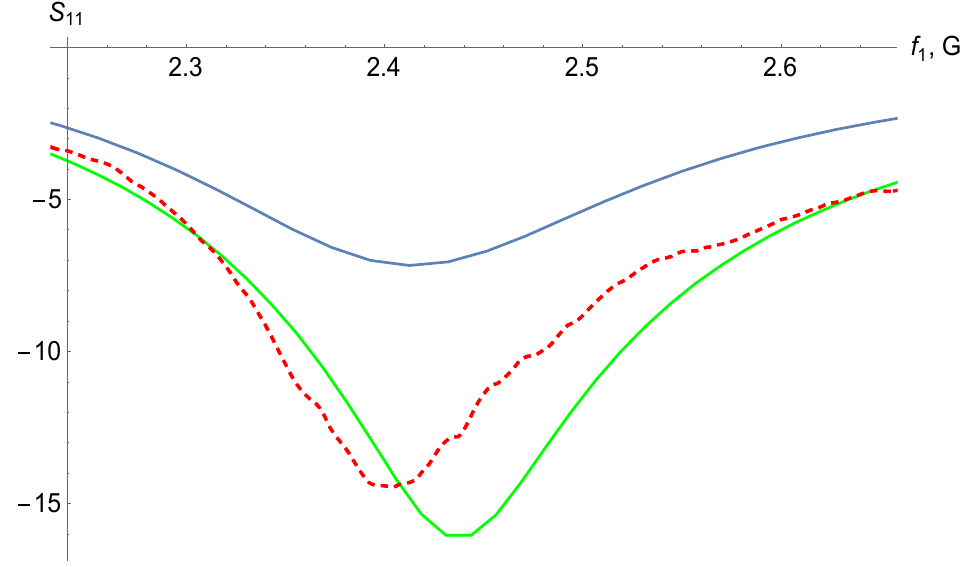
Figure 8. The dependence of the reflection coefficient S 11 on the frequency of the two antennas. The blue graph corresponds to the smallest antenna, the green graph corresponds to the simulated second antenna, and the red graph corresponds to the fabricated second antenna.